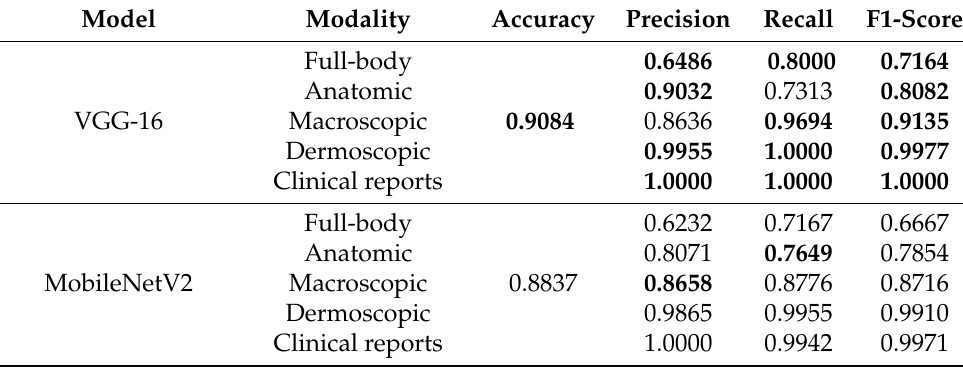
Table 2. Results of the base models tested on Task A.